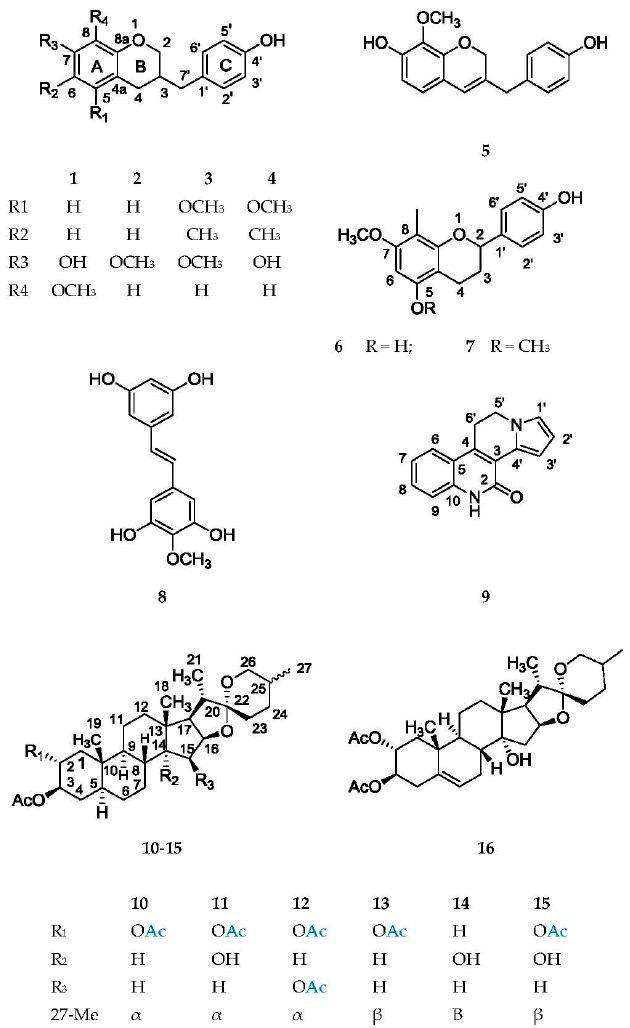
Figure 1. Chemical structures of the compounds 1 – 16 isolated from Herreria montevidensis roots.